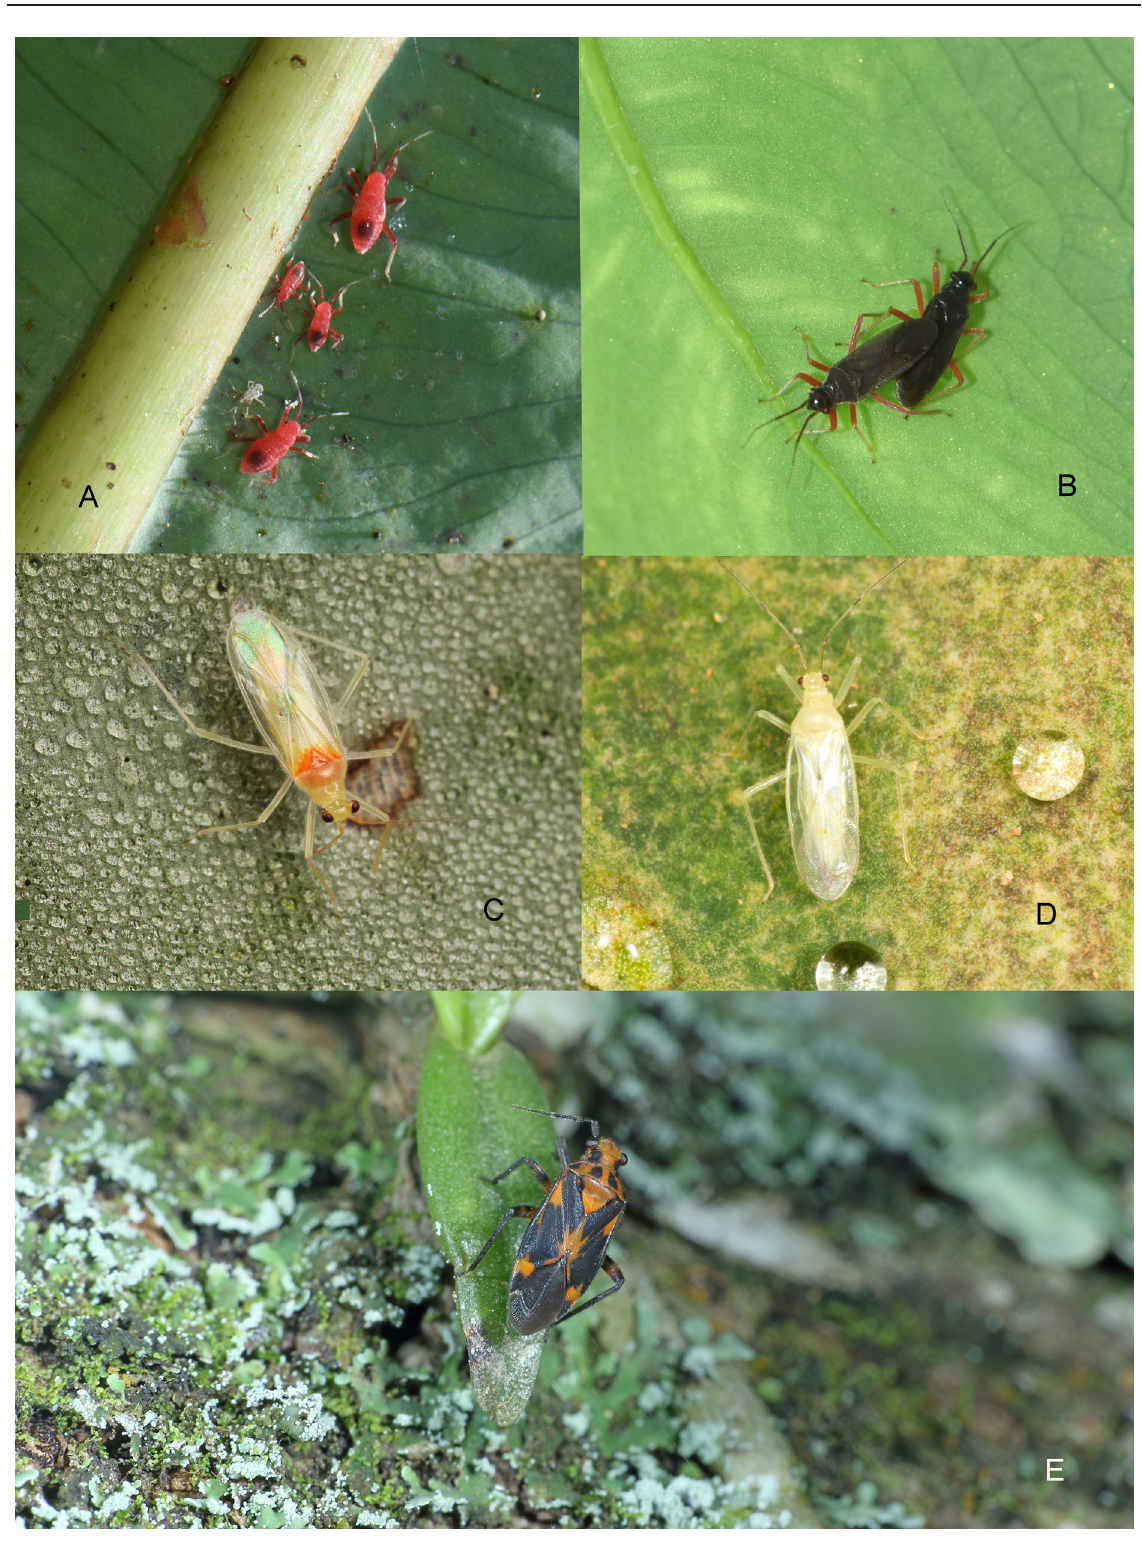
Fig. 27. Habitats and living specimens. A–B . Harpedona sanguinipes Distant, 1909 on Colocasia esculenta. A . Nymphs. B . Mating adults. C . Prodromus clypeatus Distant, 1904 on banana. D . Stonedahlia mishmiensis gen. et sp. nov. on Colocasia sp. E . Lopidolon dandeliensis sp. nov . on Diplocentrum recurvum. All specimens at